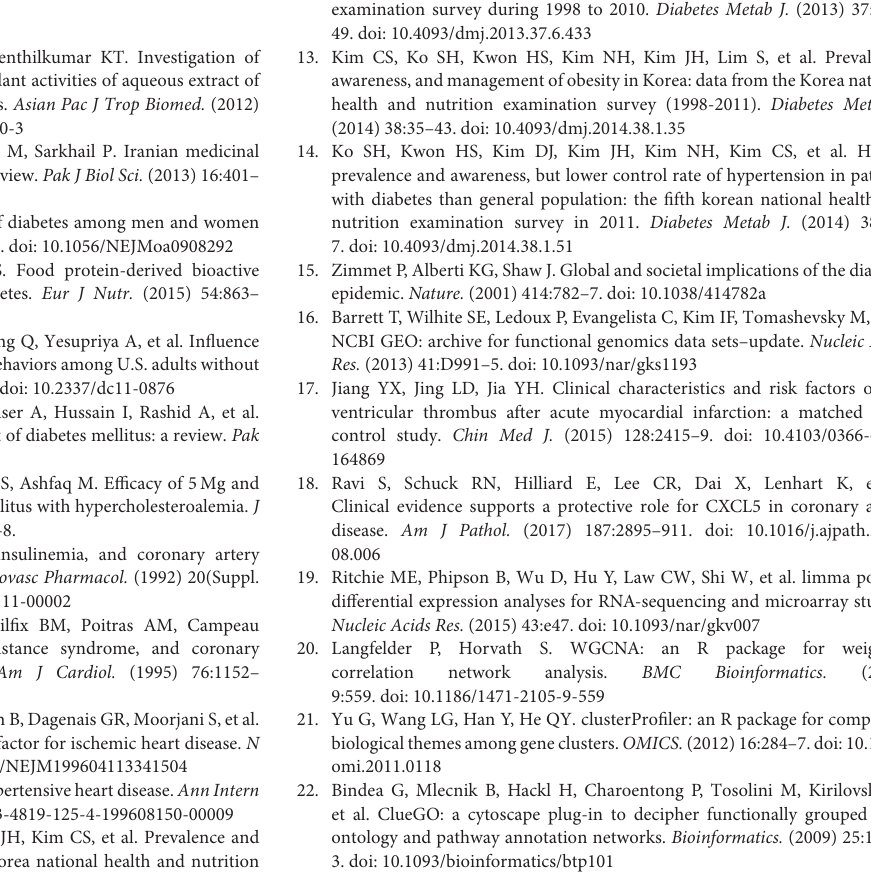
Supplementary Figure 1 | Biological process enrichment analysis using ClueGO plugin for genes in the light green